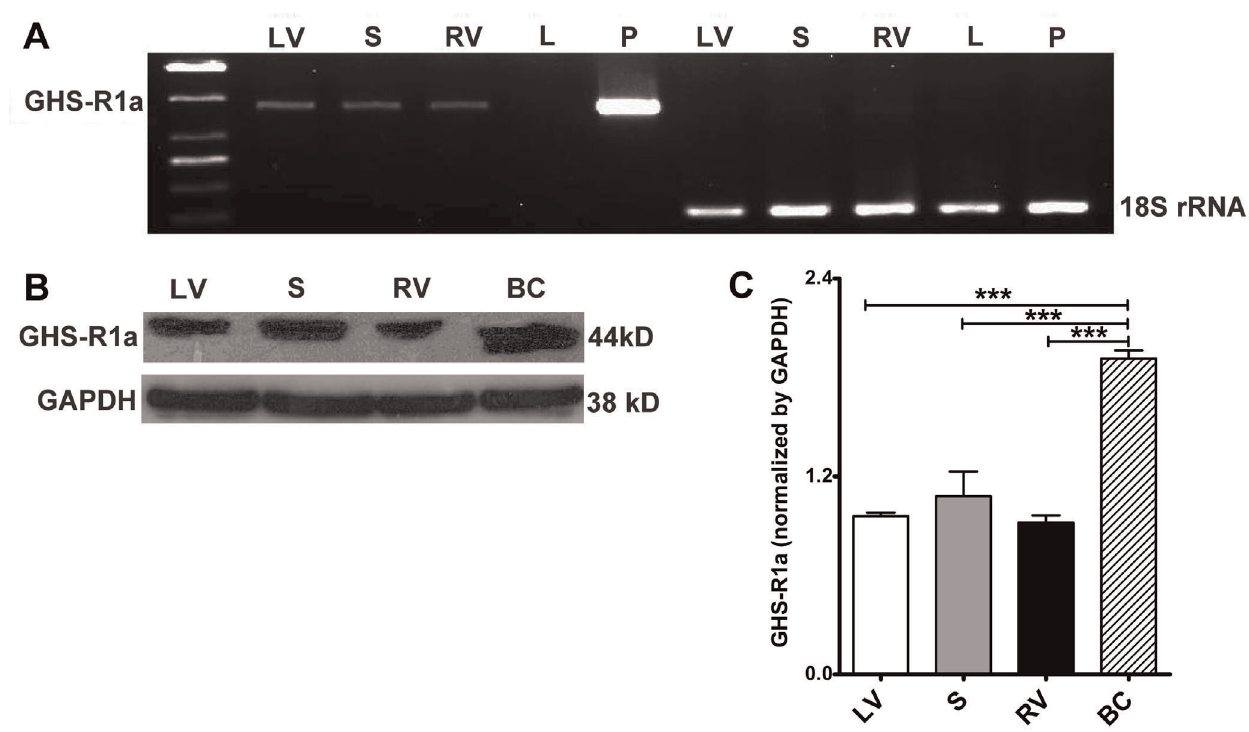
Figure 1. mRNA (A) and protein (B and C) expression of GHS-R1a in mouse heart. (A) Liver (L) and pituitary gland (P) were used as the negative and positive controls respectively. Mouse 18s rRNA was chosen as an internal control. (B) A breast cancer (BC) cell line was used as the positive control. (C) n = 3 for Western blots, data are shown as means 6 S.E.M. and analyzed by One-way ANOVA with Tukey’s post hoc test. *** P , 0.001 vs BC group. GHS-R1a mRNA and protein are expressed in the left ventricle (LV), septum (S) and right ventricle (RV) of the mouse